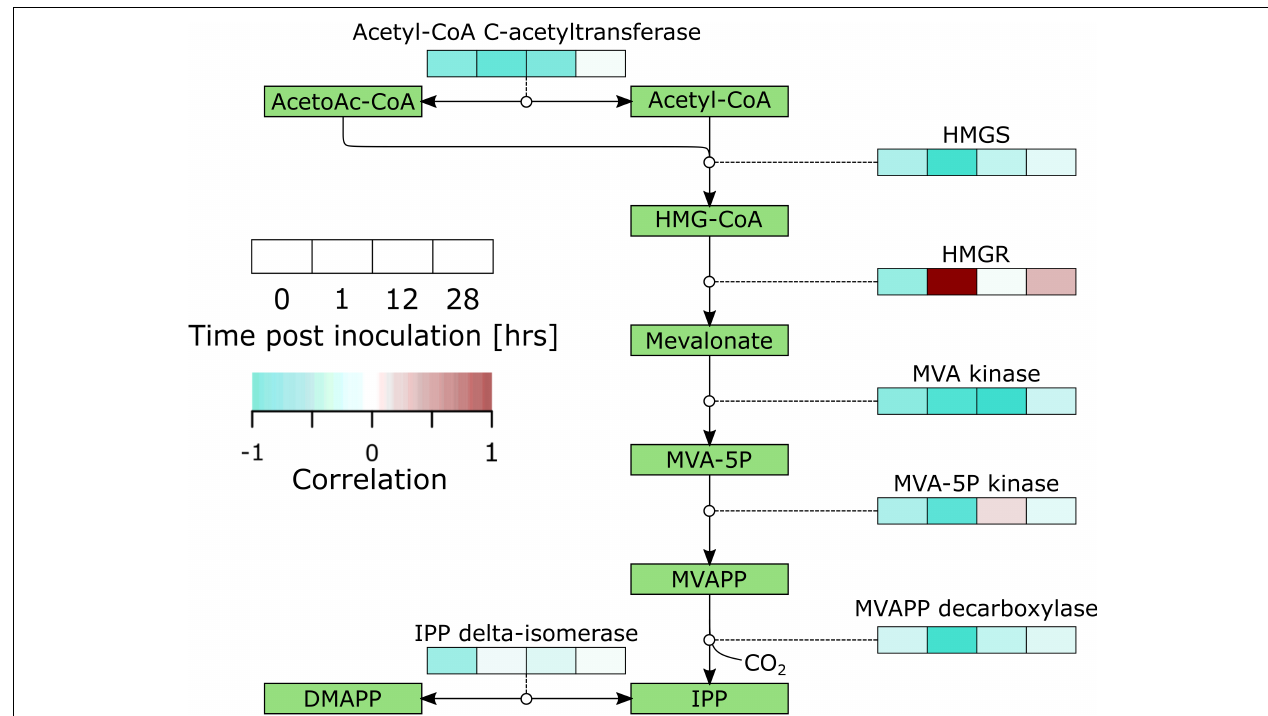
FIGURE 5 | Overview of correlations of the mevalonate pathway gene expression with lesion diameter at 96 hpi in B. cinerea inoculated apples. Heat maps were constructed from genes with significant differential expression. AcetoAc-CoA, Acetoacetyl-CoA; HMG-CoA, Hydroxymethylglutaryl-CoA; HMGS, HMG-CoA